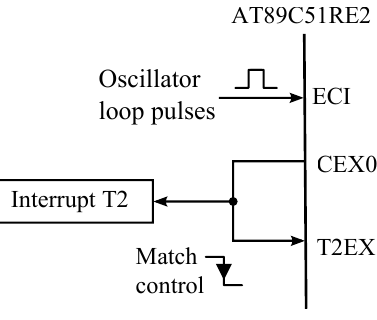
Figure 8. Interconnections for